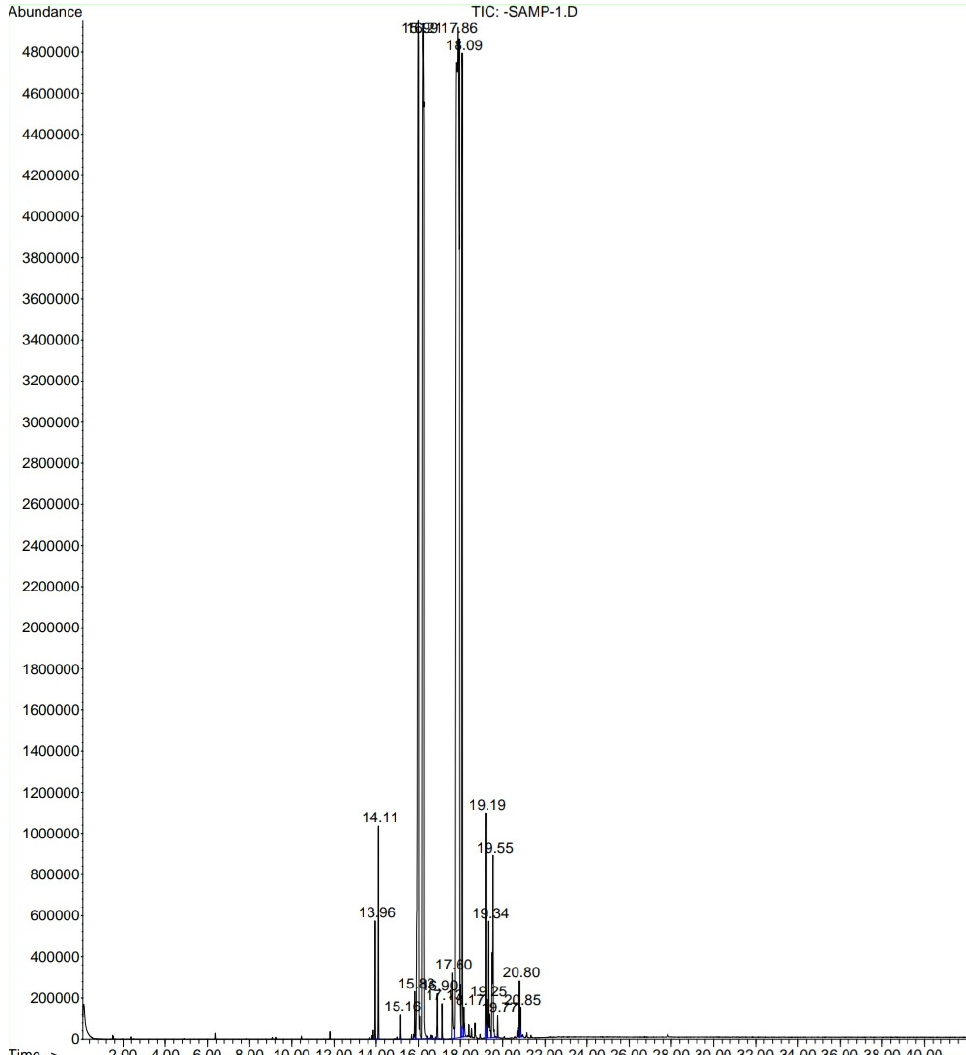
Figure 8. GC/MS chromatogram of the biodiesel from chicken feet oil.